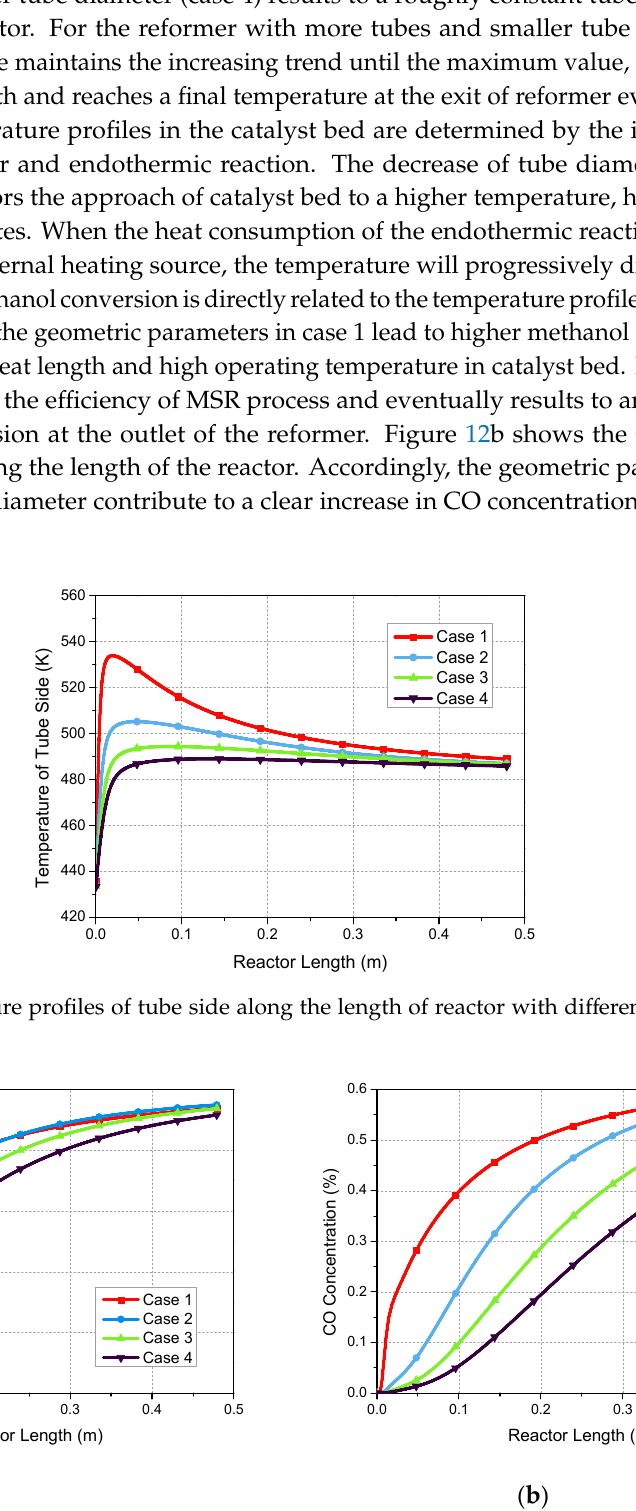
Figure 12. Profiles of ( a ) methanol conversion, ( b ) CO concentration along the length of reactor with different number and diameter of tubes.